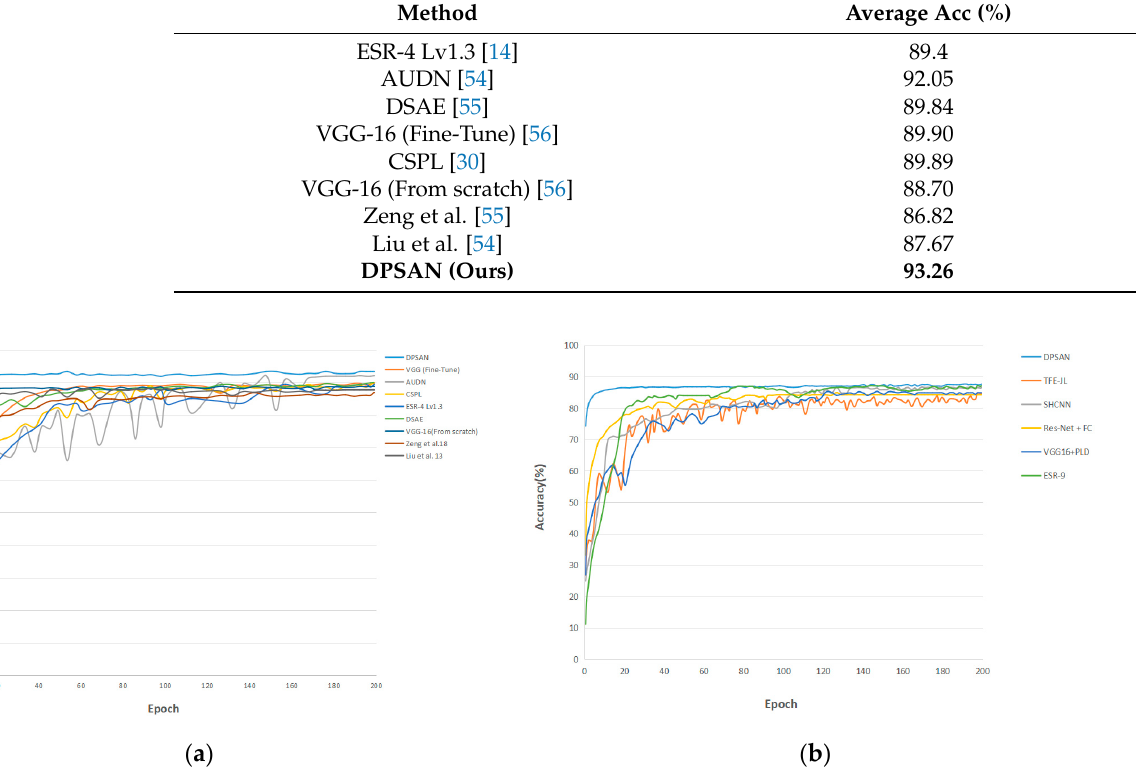
Figure 8. Results of DPSAN with other methods are shown. ( a ) Results on the CK+ dataset; ( b ) Re- sults on the FERPLUS